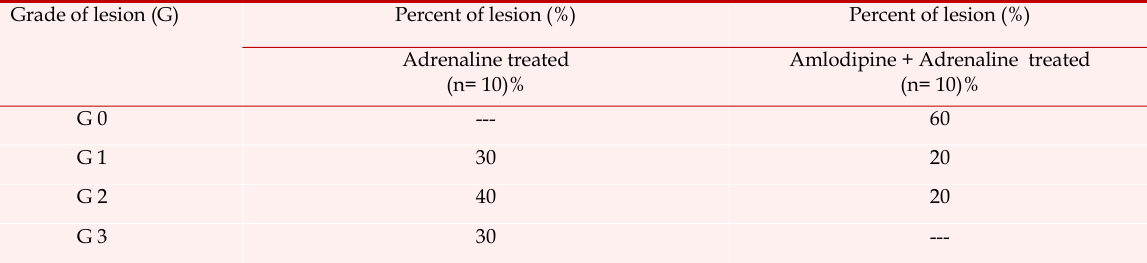
Showing the percent of lesion after pretreatment with amlodipine in adrenaline treated rats Percent of lesion (%) Percent of lesion (%) Grade of lesion (G)